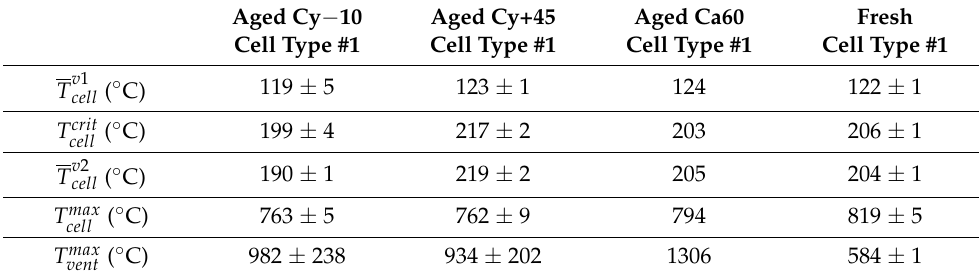
Table 3. Thermal parameters of failing aged cell type #1 cells in overtemperature abuse tests in comparison to fresh